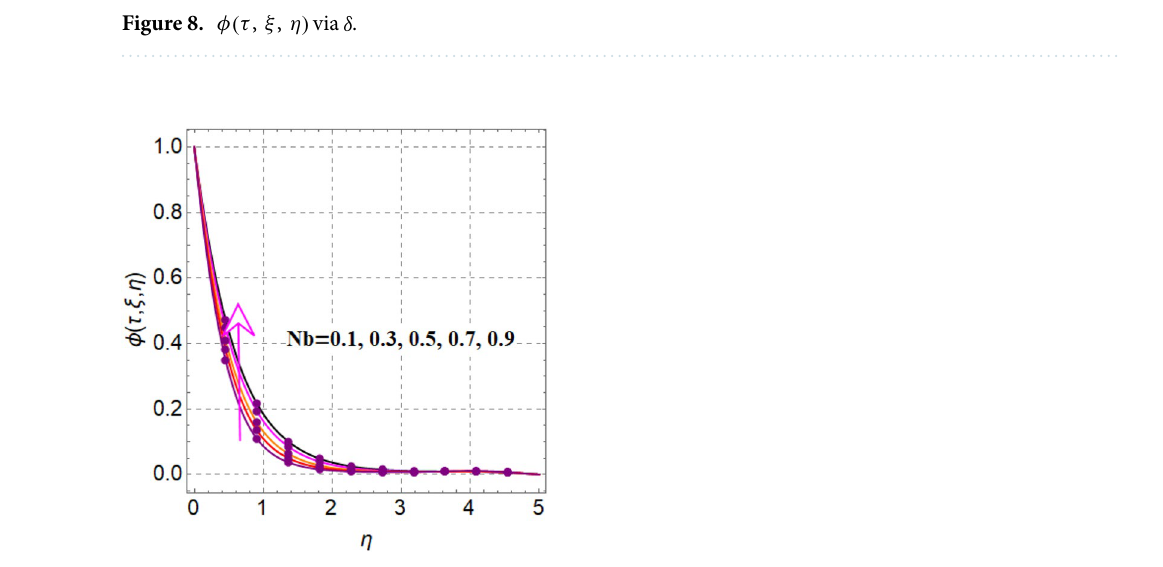
Figure 9. φ(τ , ξ , η) via Nb .